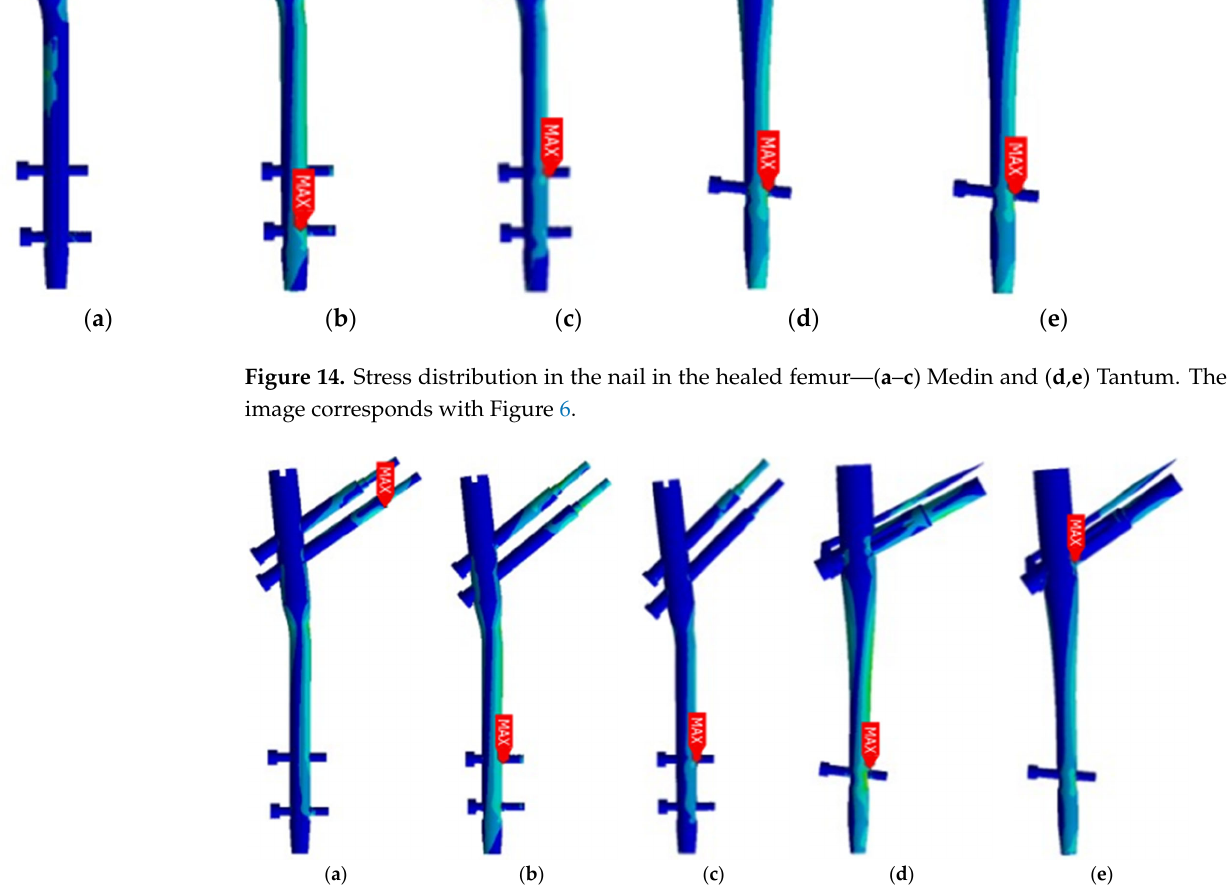
Figure 15. Stress distribution in the nail in the broken femur—( a – c ) Medin and ( d , e ) Tantum. The image corresponds with Figure 7.